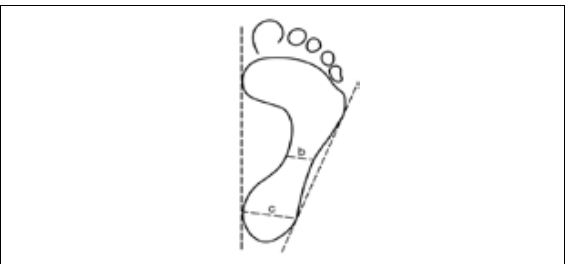
Figure 3. The Staheli Index (Onodera et al., 2008) For calculation of the Clarke’s angle (CLA) the line “AC” was drawn between point A and the apex of the concavity of the arch of the footprint (point C). The CLA is the angle between lines “AB” and “AC”. The MLA is classified as follows: 55º is overarched; 42–54º normal MLA; 31–41º flattened; 30º and below is flatfoot (Clarke,